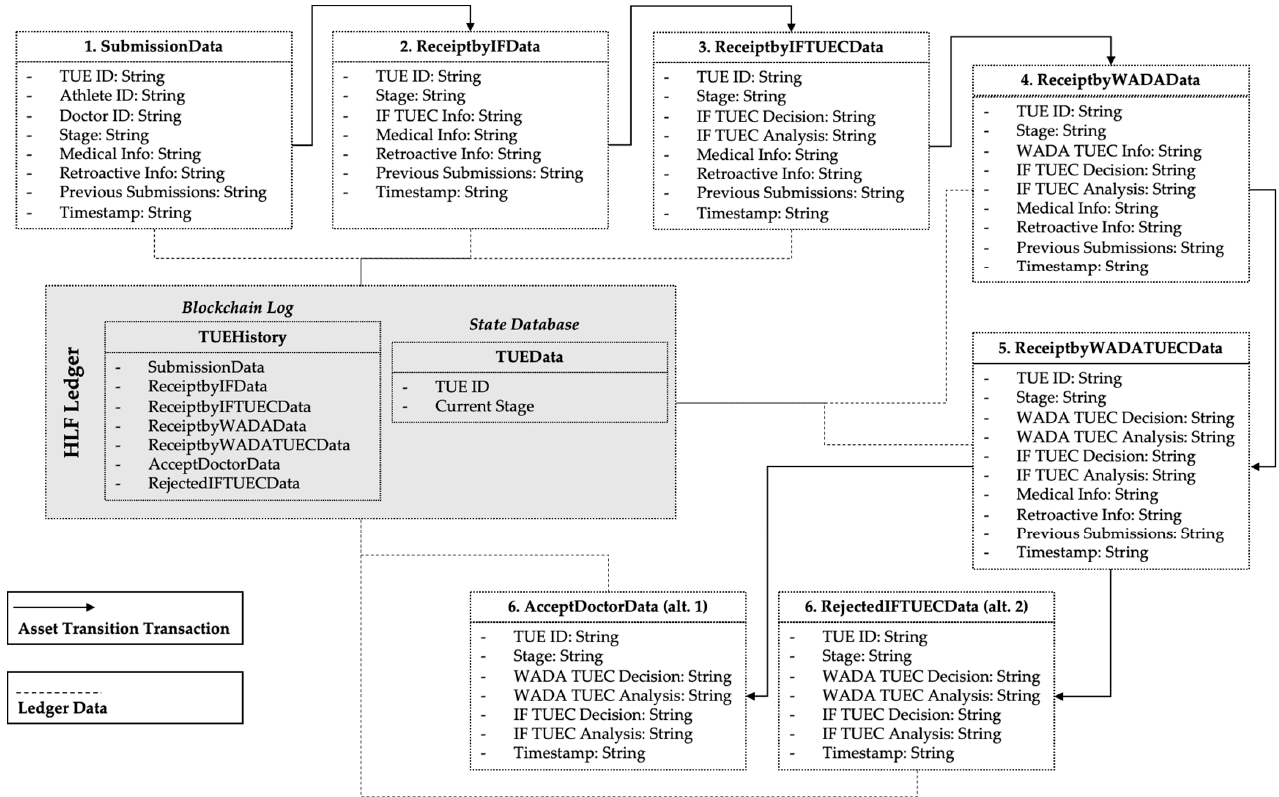
Figure 5. TUE request–asset lifecycle. References: [83,84].